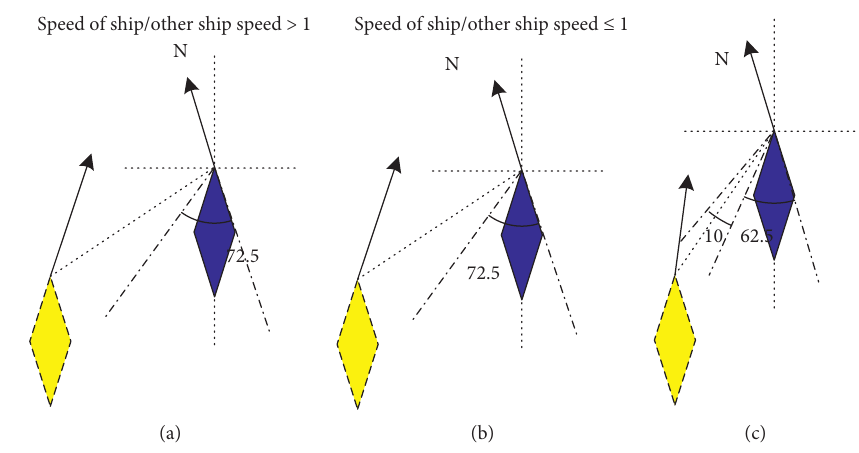
Figure 14: Cross situation (own ship is a direct ship).